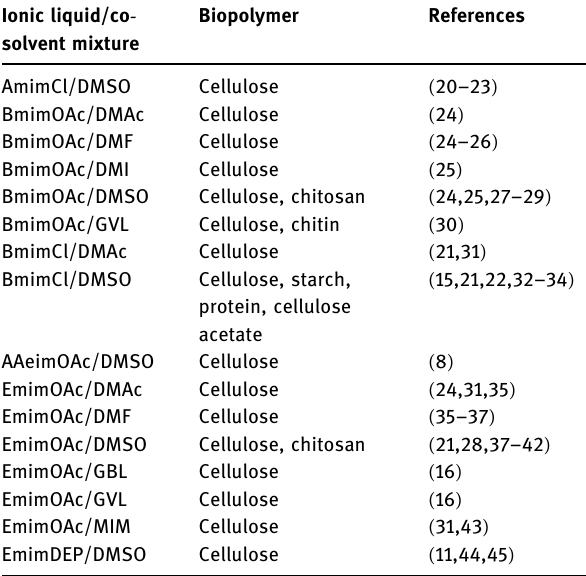
Table 3: Examples of imidazolium - based ionic liquid/co - solvent mixtures applied in the dissolution of cellulose and other biopolymers Ionic liquid/co - solvent mixture